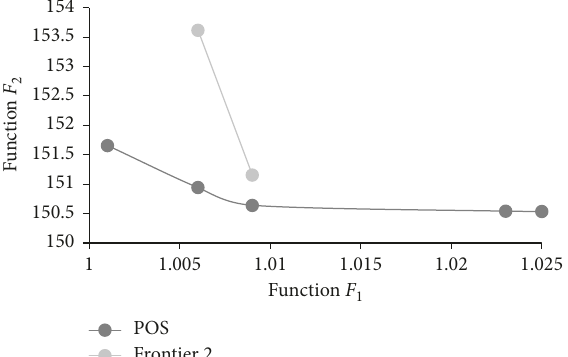
Figure 16: Objective functions F model RC-9.